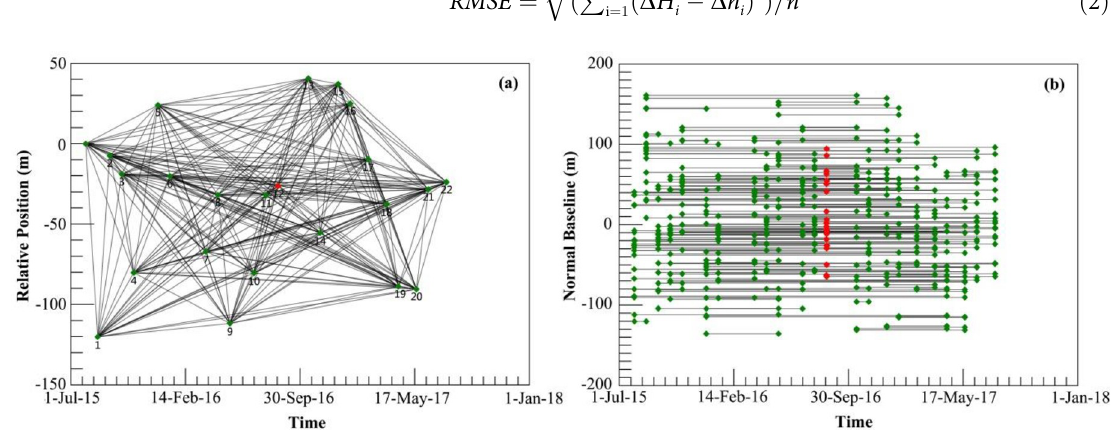
Fig 2. Relative position and time baseline of the imagery. (a) Relative position of interferometric pairs; (b) time-baseline interferometric pairs. The red diamond is the super master image. Black lines represent interferometric pairs. Green dots denote slave images.